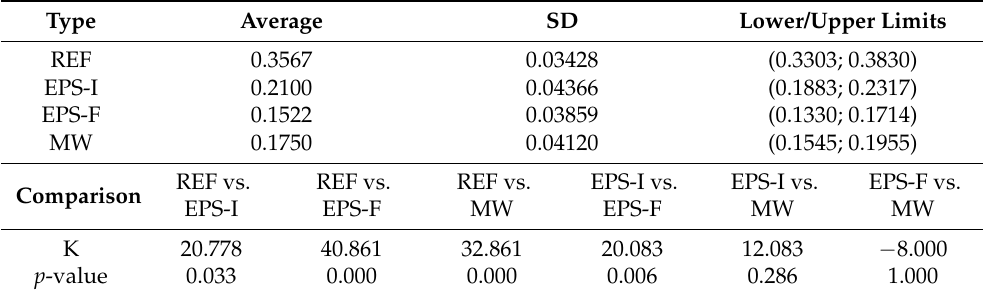
Table 9. Statistical analysis for the bonding strength test (MPa) for each group of mortar and its comparison.